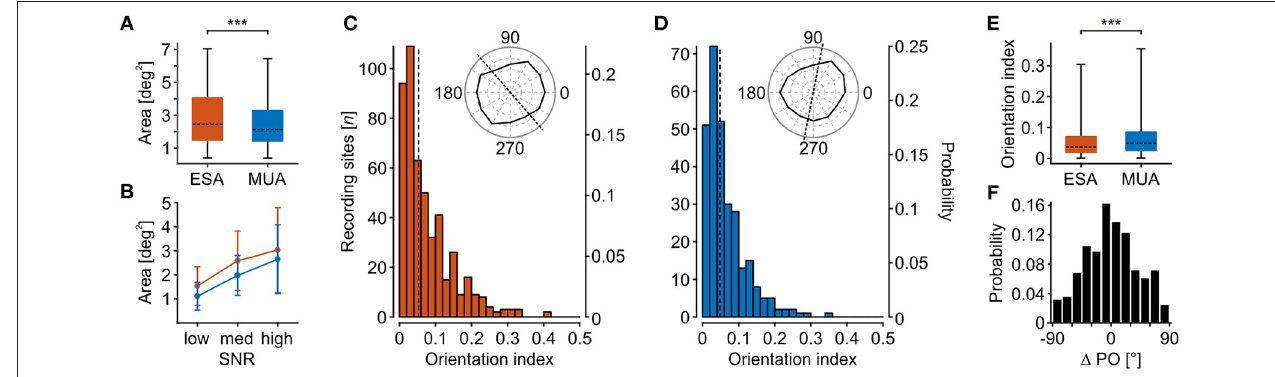
FIGURE 4 | Comparison of stimulus selectivity between ESA and MUA. (A) RF area of recording sites with significant visually evoked response modulation for both ESA and MUA ( N 385). (B) RF area as a function of SNR for same units as in (A) . Error bars indicate S.D. (C,D) Distribution of orientation indexes for ESA (C) and = MUA (D) . Dotted lines indicate median OI. Polar plot insets show exemplary orientation selective responses at median OI value for either signal type. (E) Direct comparison of orientation selectivity of units with significant orientation-selective responses for both MUA and ESA ( N preferred orientation ( 1 PO) for same units as in (E) . Boxplot conventions as in Figure 2 . Asterisks indicate statistical difference for α < 0.005%